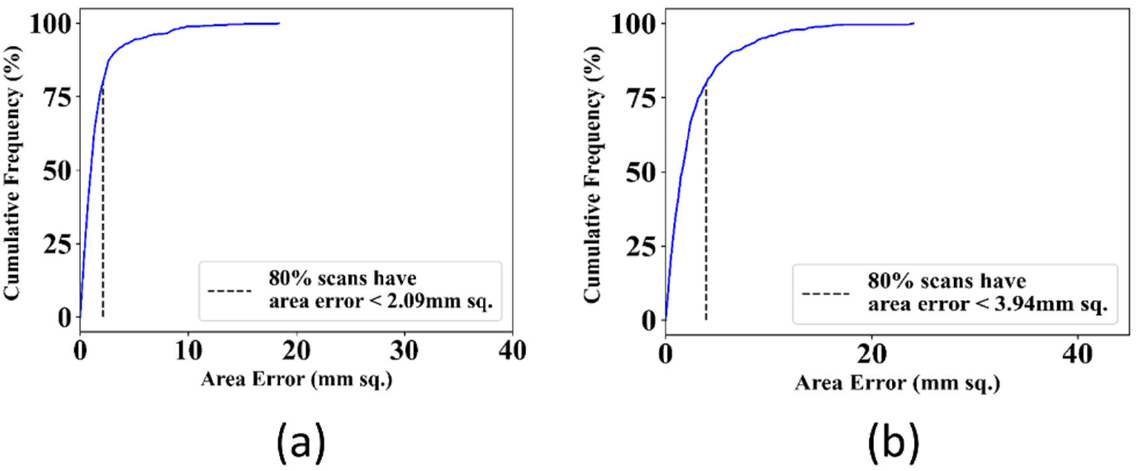
Figure 18. Cumulative distribution curves for area error between GT and AI-estimated masks by ( a ): UNet model, ( b ): UNet+ model.